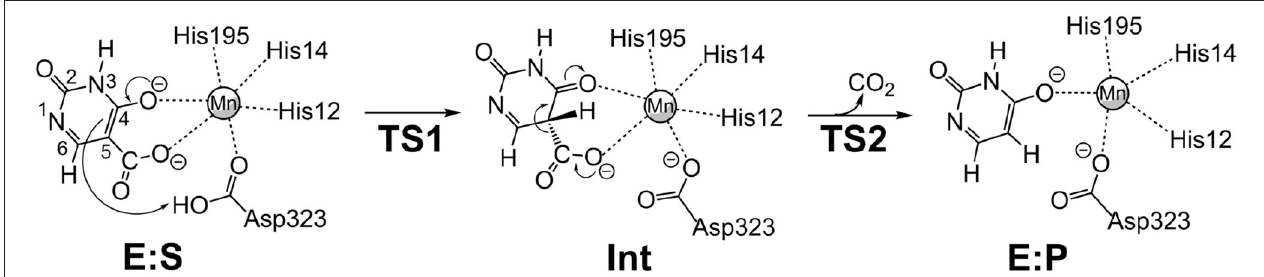
SCHEME 2 | Proposed mechanism for the IDCase-catalyzed decarboxylation of 5-carboxyuracil ( 1a ) on the basis of current calculations.